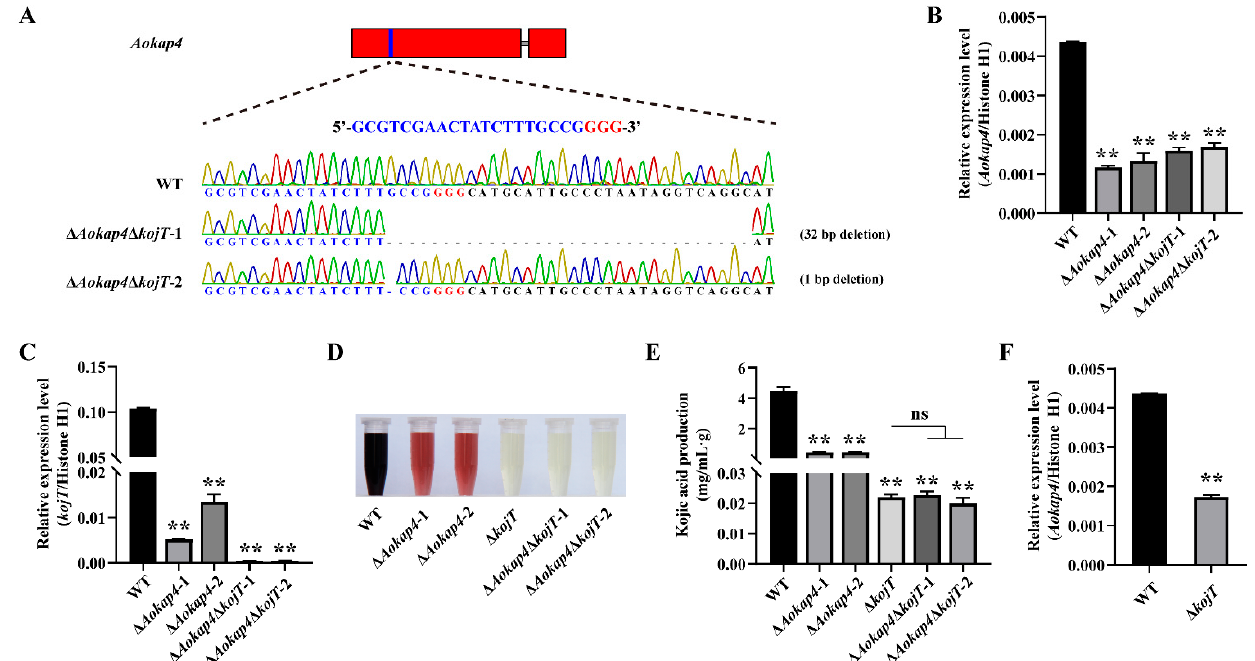
Figure 5. Disruption of kojT in Aokap4- deletion mutant inhibited kojic acid production. ( A ) Construction of the double-deletion mutants of kojT and Aokap4 using a CRISPR/Cas9 system. The targeted position is highlighted by the blue box. The Cas9 targeted sequence for Aokap4 is indicated in blue and the PAM sequence is in red. The number and type of mutants in the Aokap4 gene are indicated on the right. ( B , C ) Transcriptional expression of Aokap4 ( B ) and kojT ( C ) in the wild-type and double-deletion mutants of kojT and Aokap4 . Total RNA was extracted from the mycelia cultivated in the modified CD liquid medium for four days at 30 ◦ C. ( D ) Kojic acid produced by the wild-type (WT), Aokap4- deletion mutants ( ∆ Aokap4 -1 and ∆ Aokap4 -2), kojT -disrupted strain ( ∆ kojT ) and double-deletion mutants of kojT and Aokap4 ( ∆ Aokap4 ∆ kojT -1 and ∆ Aokap4 ∆ kojT -2) cultured in the modified CD liquid medium for seven days at 30 ◦ C. ( E ) The amount of kojic acid generated by WT, ∆ Aokap4 -1, ∆ Aokap4 -2, ∆ kojT , ∆ Aokap4 ∆ kojT -1 and ∆ Aokap4 ∆ kojT -2. These fungal strains were incubated in the modified CD liquid medium for seven days at 30 ◦ C. ( F ) The mRNA level of Aokap4 in the wild-type and kojT- deletion strains. ** p < 0.01 represents significant differences between the wild-type and mutants, and ns indicates no significant difference.